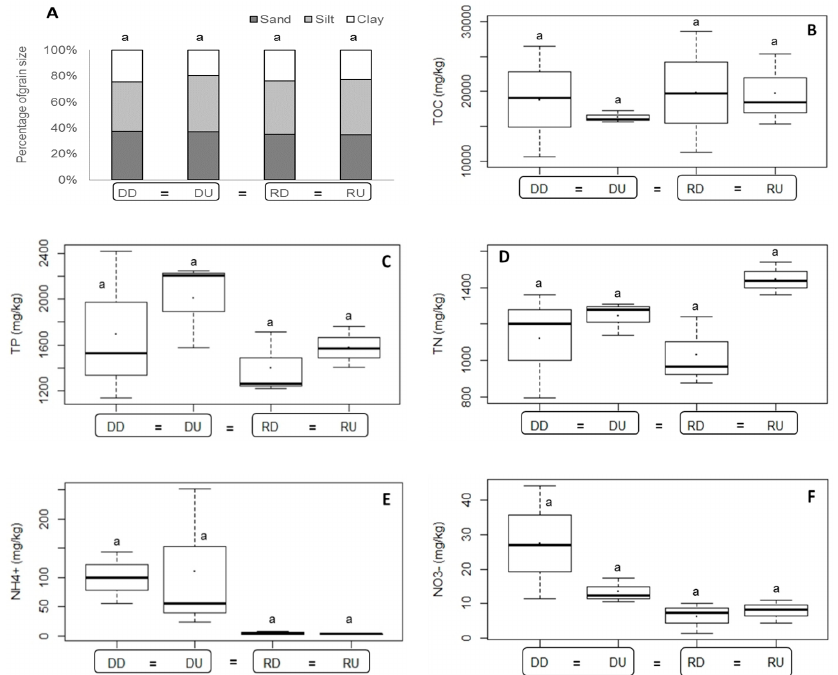
Figure 3. Box and whisker plots and mean values (.) for heavy metals including Fe ( A ), Cu ( B ), Cr Figure A1. The grain size (sand, silt, clay in graph ( A )) and nutrient concentrations (TOC (graph ( C ), Hg ( D ), Se ( E ), Pb ( F ), As ( G ), Cd ( H ), H 2 S ( I ) and CH 4 ( J ) concentration in sediment of the ( B )), TP ( C ), TN (graph ( D )), NH 4 + (graph ( E )) and NO 3 − (graph ( F )) in sediment of Ba Lai and Ham estuarine Luong estuary.